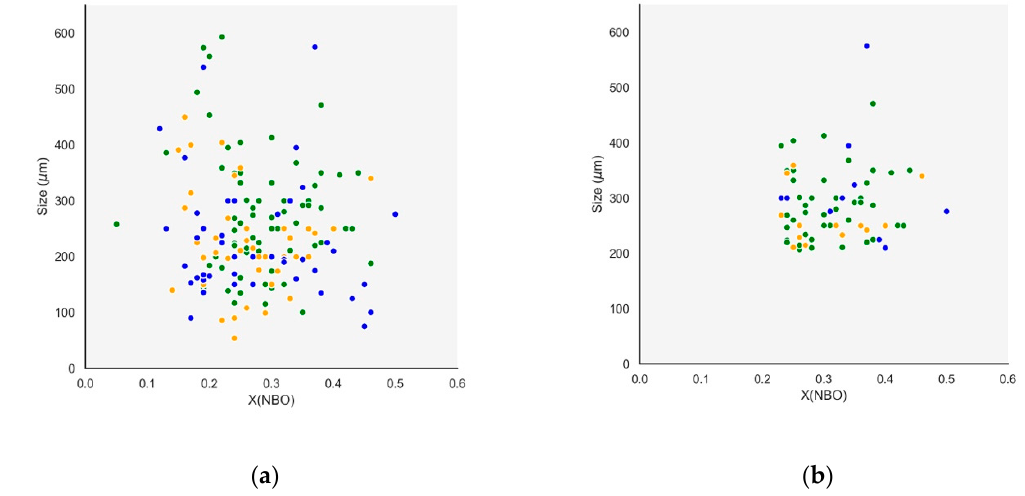
Figure 1. ( a ) Plot comparing non-bridging oxygens (X(NBO)) and size for all 162 impact glasses with ‘good’ (green), ‘fair’ (yellow), and ‘poor’ (blue) age assessments. ( b ) Comparison of 74 glasses after imposing a minimum lower size limit of 200 μ m and an X(NBO) ≥ 0.23. Data in both figures are from [6–10] and Table 1.